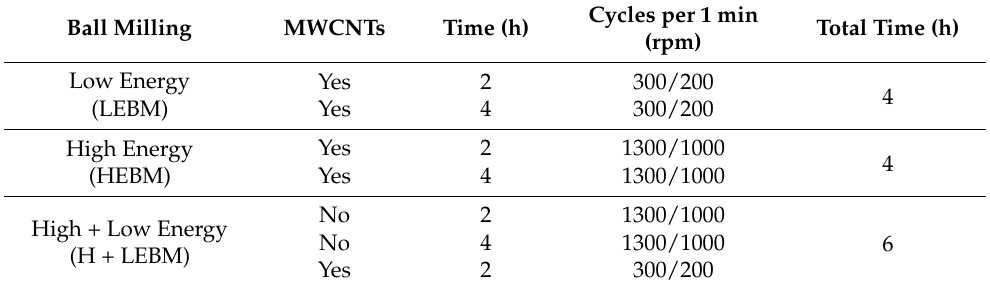
Table 1. Route of ball